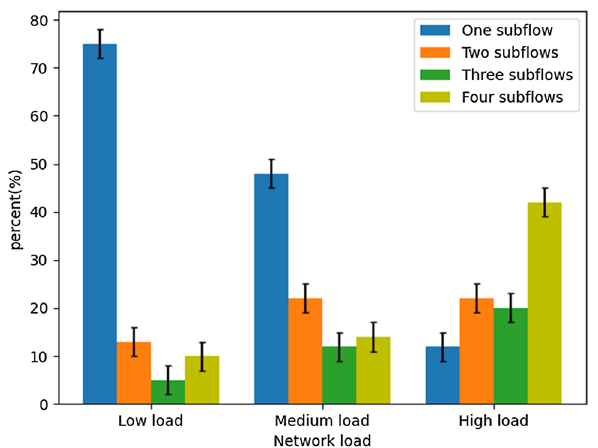
Fig. 8 The adjustment of the algorithm about the sub-path A level-3 fat-tree network with 16 processing Fig. 9 Experimental network